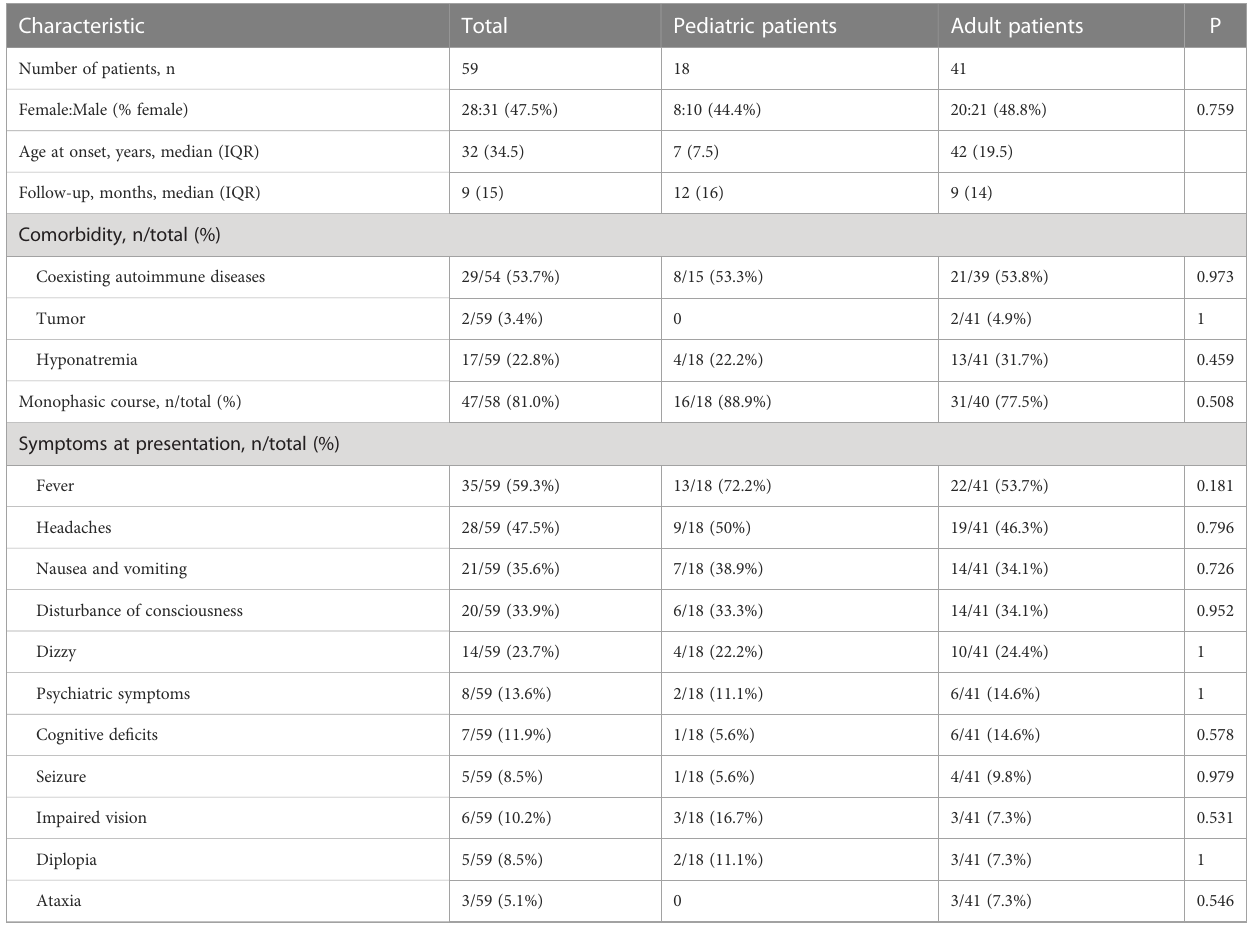
TABLE 1 Demographics and clinical features of GFAP-IgG